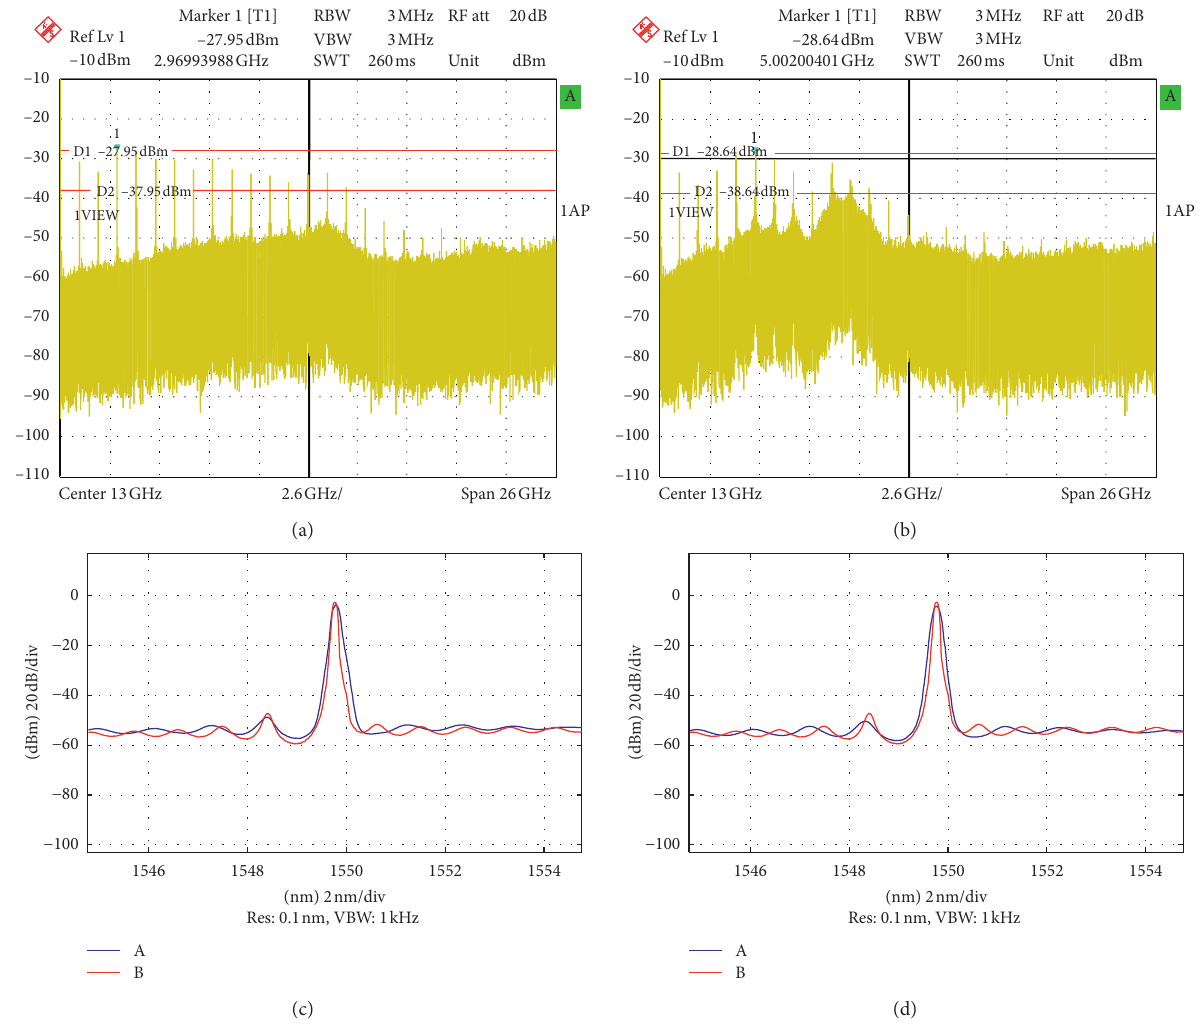
Figure 2: Electrical spectrum of the MFC when the modulation signal frequency is 1GHz and the attenuator coefficient of VOA is 11dB (a) and 20dB (b). The optical spectrum when the attenuator coefficient of VOA is 11dB (c) and 20 dB (d) For (c) and (d), curve A denotes the optical spectrum of the optical signal generated from SL with the injection from SFP module. Curve B denotes the optical spectrum of the SFP